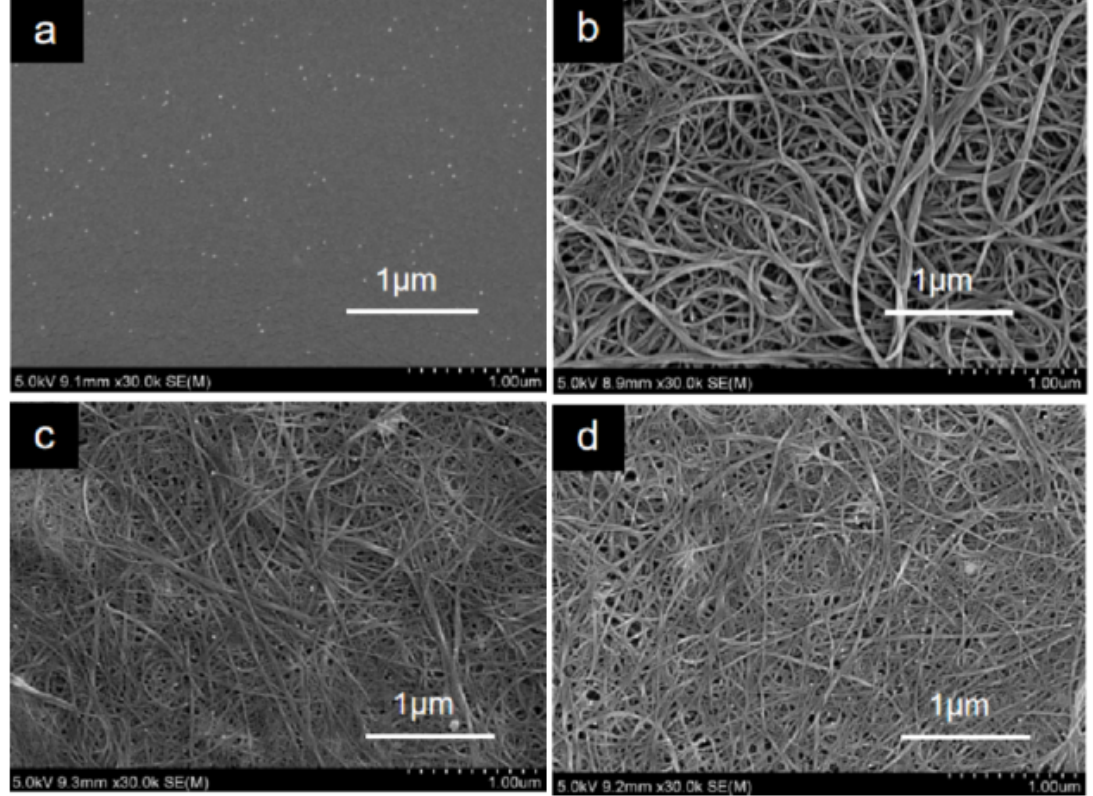
Figure 3. SEM images of ( a ) PBDT–C–BT film, ( b ) SWCNTs, ( c ) PBDT–C–BT / 50 wt % SWCNTs and ( d ) / F / 50 wt % 4 TCNQ-doped PBDT–C–BT